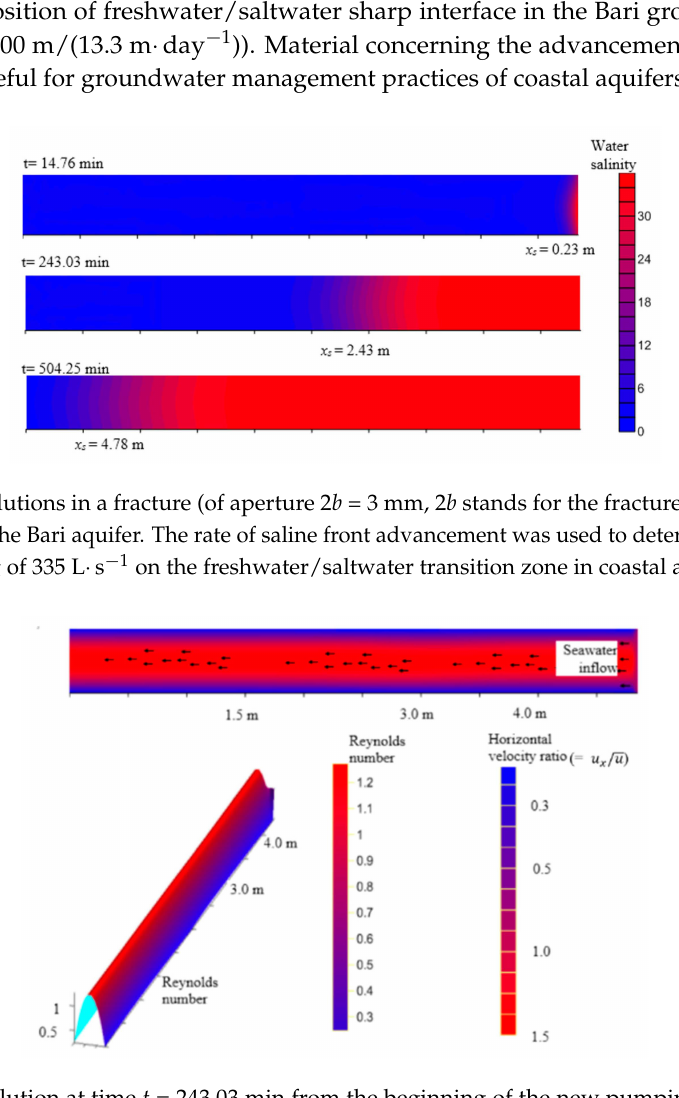
Figure 6. N-S solution at time t = 243.03 min from the beginning of the new pumping of 335 L ¨ s ´ 1 : horizontal flow velocity magnitude map due to freshwater/saltwater mixing in the fracture, and Reynolds number